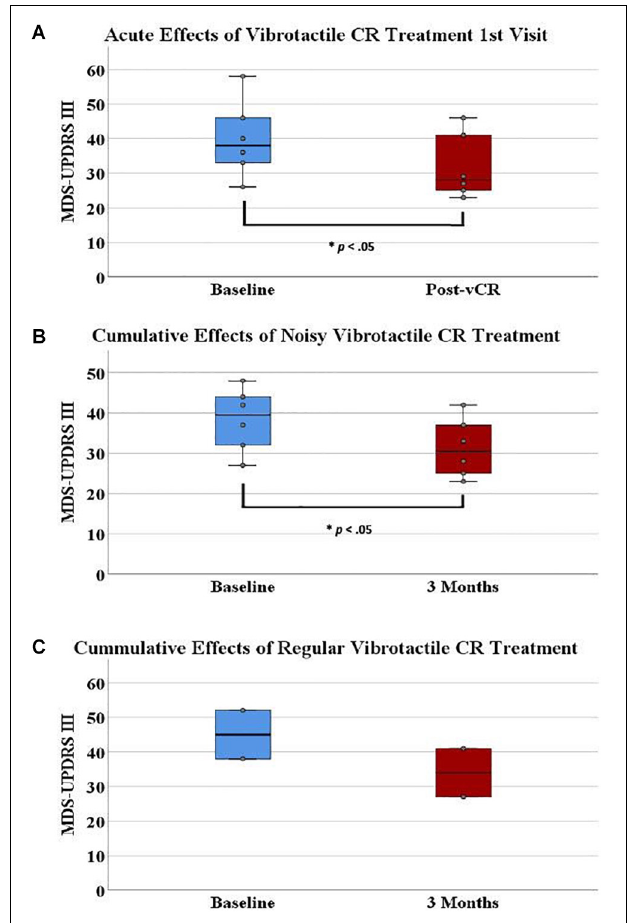
FIGURE 5 | (A) On the first visit, Parkinson’s disease (PD) patients displayed a significant acute effect for vibrotactile coordinated reset (vCR) treatment. Specifically, Movement Disorders Society-Unified Parkinson’s Disease Rating Scale (MDS-UPDRS) III pretreatment scores ( M = 39.833, SD = 11.14) significantly decreased after 4 h of stimulation ( M = 31.833, SD = 9.38). (B) Additionally, MDS-UPDRS III pretreatment scores ( M = 38.33 ± 7.86) significantly decreased after 3 months of vCR treatment ( M = 32.33, SD = 7.80). Panel (C) represents baseline ( M = 45, SD = 9.89) and 3-month ( M = 34, SD = 9.89) MDS-UPDRS III data for the two patients in study 2 who received regular vCR. While no statistics can be used due to the small sample size, regular vCR results are represented visuallyfor comparison to the noisy vCR results. Regardless of vCR type, these findings suggest